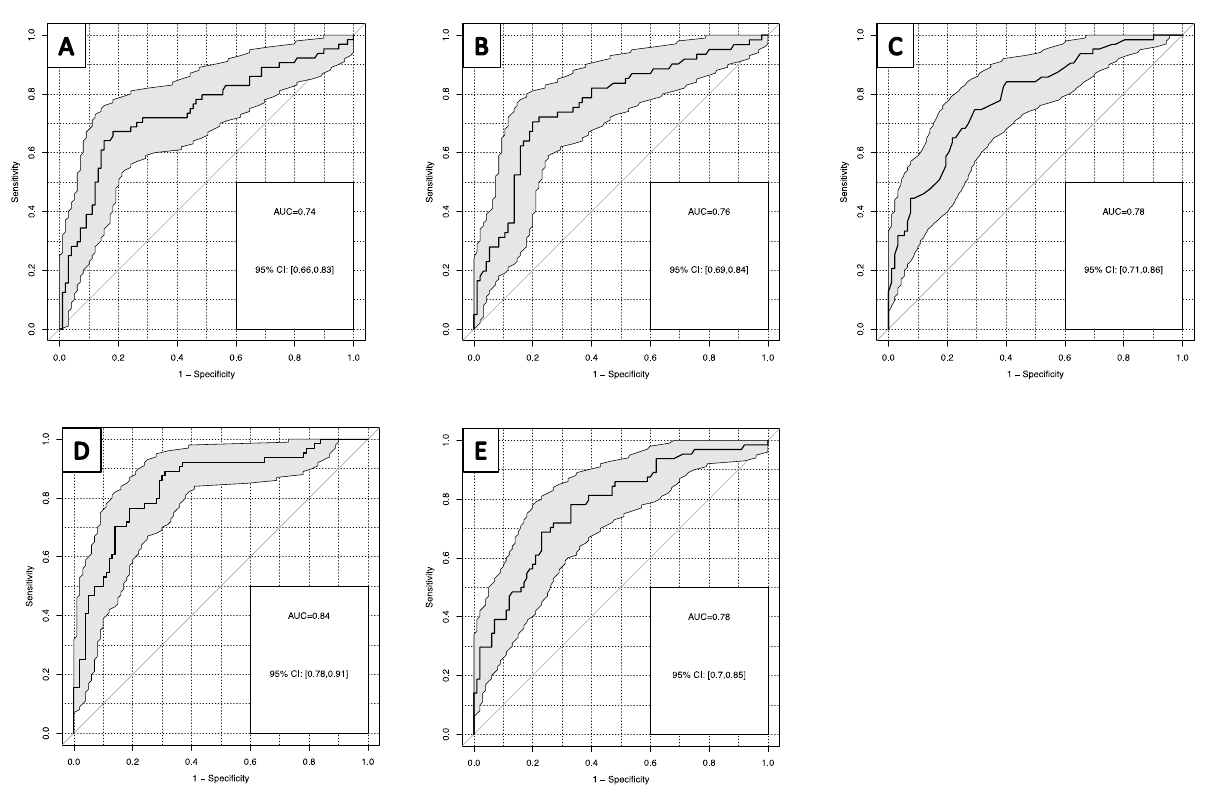
Figure 4. Receiver operating characteristic curves for the discrimination of severe multiple trauma and all other trauma groups for: ( A ) cfDNA in serum; ( B ) cfDNA in plasma; ( C ) hemoglobin; ( D ) hemoglobin and cfDNA in plasma; ( E ) random forest model of all lab parameters for severe multiple trauma versus other severity groups.